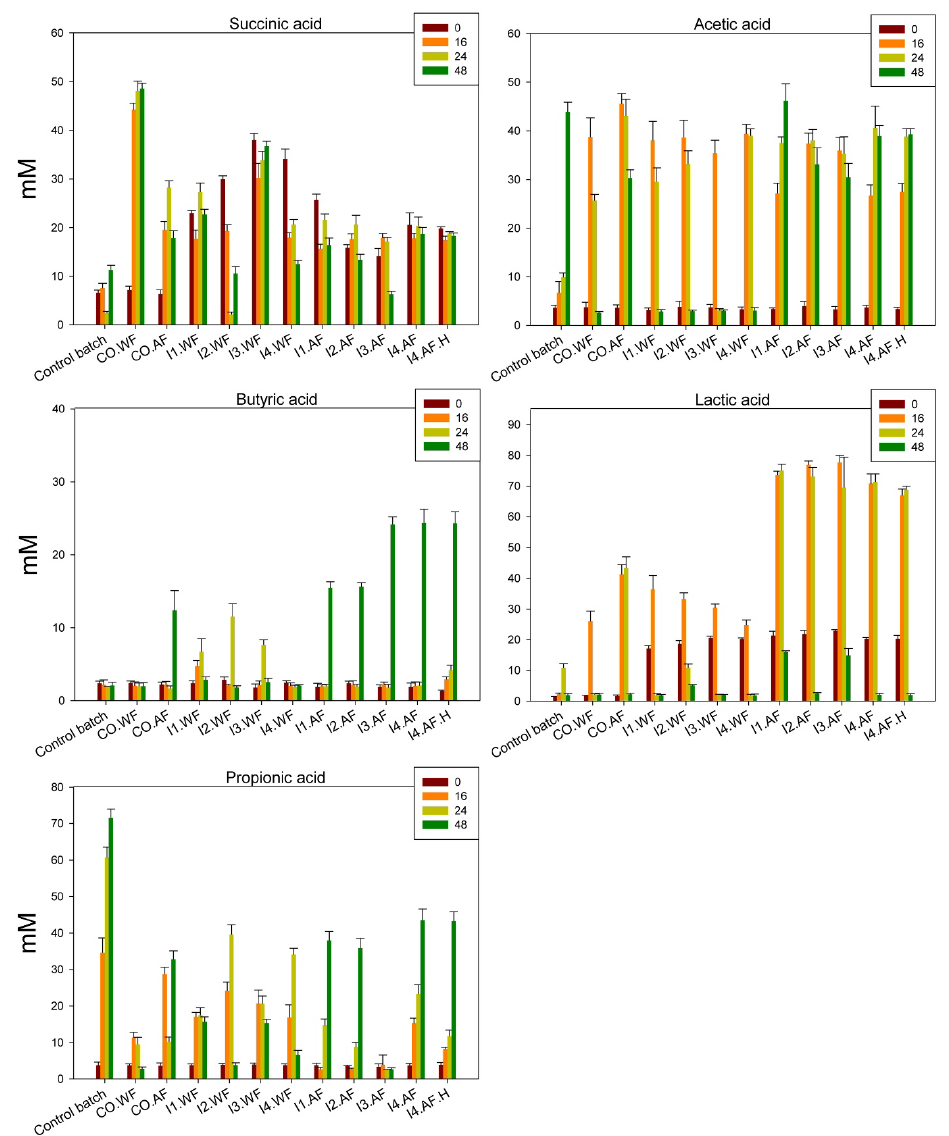
Figure 4. Concentrations (mM) of main organic acids in fecal batch culture over 48 h of incubation. Fecal batches were supplemented with ice creams, and a batch culture without supplementation was used as a negative control.